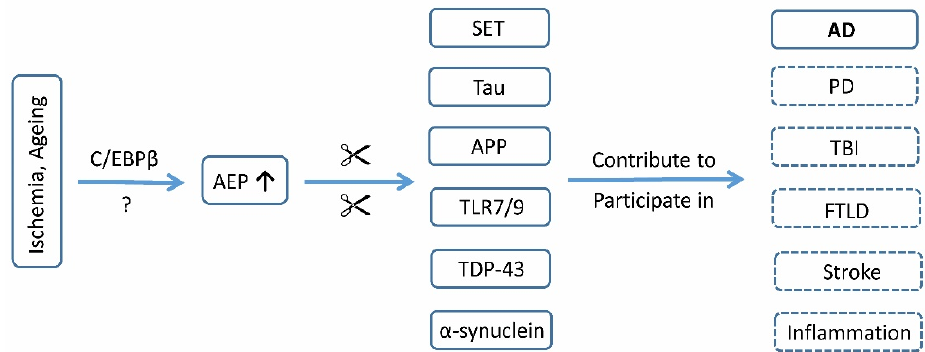
Figure 2. Involvement of AEPs in Alzheimer and other neurological diseases. Aging and ischemia upregulate AEPs in the brain, probably through activation of C/EBPβ or other transcriptional regulation mechanisms (?). The cleavable substrates of AEPs include SET, tau, APP, α-synuclein, TDP-43, and TLR7/9. Upregulated AEPs contribute to the pathogenesis of Alzheimer’s disease (AD), and may participate in the progression of Parkinson’s disease (PD), traumatic brain injury (TBI), frontotemporal lobar degeneration (FTLD), stroke, and neuroinflammation.